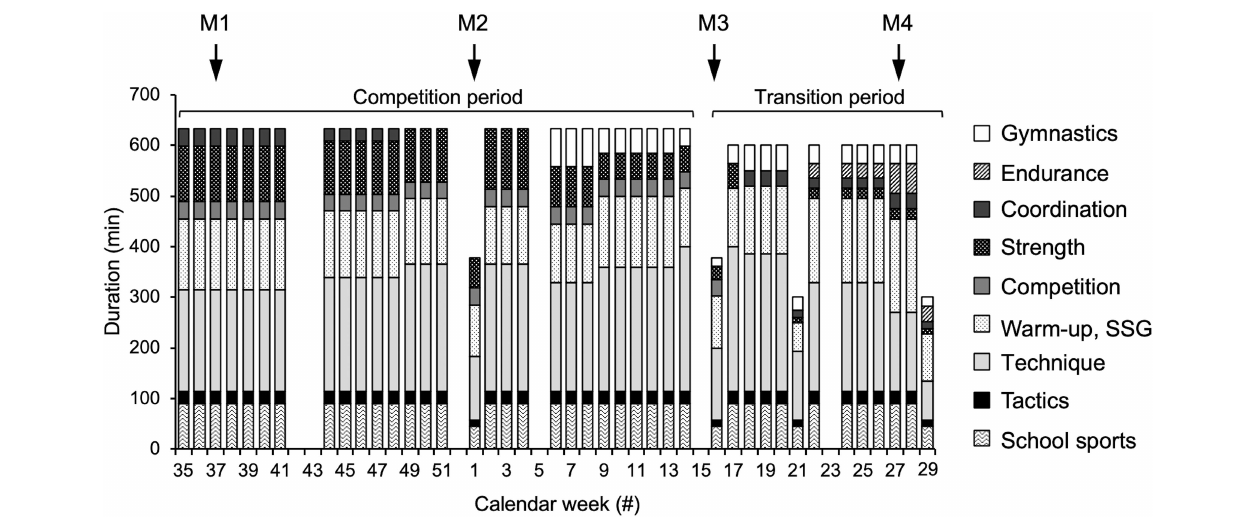
FIGURE 1 | Total duration of respective training components of the adolescent handball athletes per calendar week. In the experimental group, the functional high-load exercise intervention was integrated into the strength training component, without a change of overall duration. Tendon pain, muscle strength and tendon mechanical properties were measured at the beginning (M1), during (M2) and at the end of the competition period (M3) and at the end of the transition period (M4) of the adolescent athletes’ season. SSG, small sided